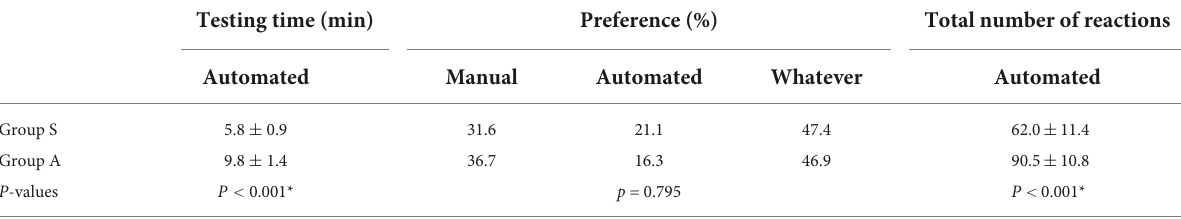
TABLE 2 Differences in test time, preference on the testing methods, and the total number of reactions between Groups A and